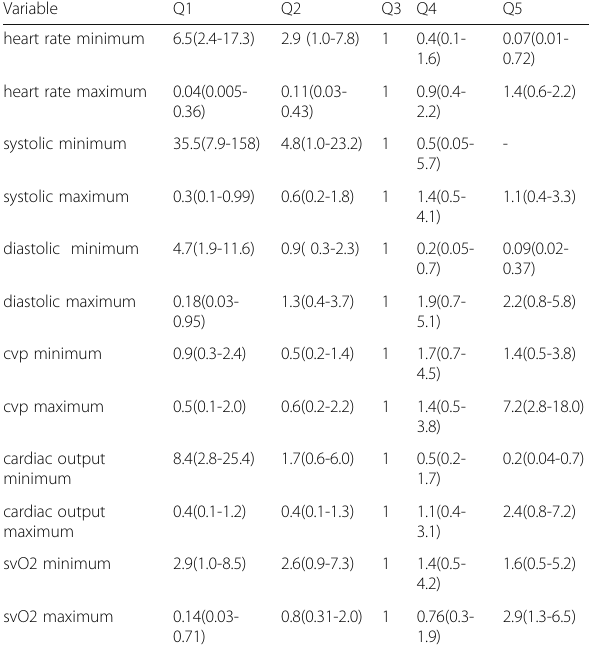
Table 1 (abstract 001756). Odds ratio for hospital death after cardiac